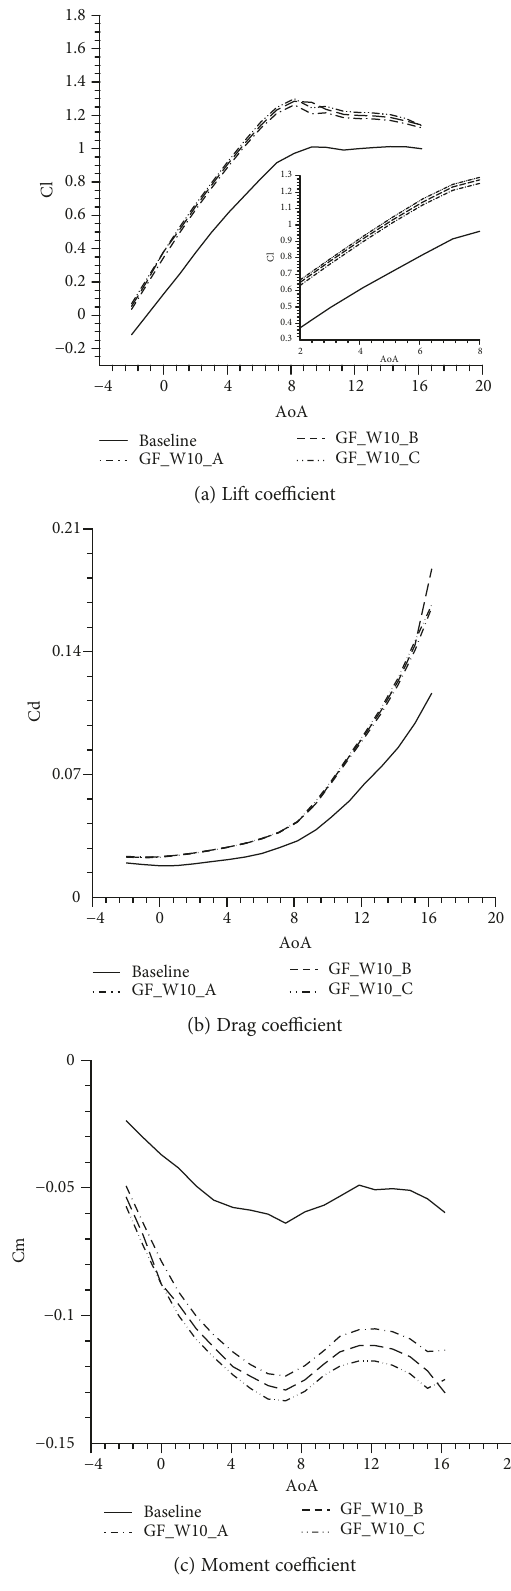
Figure 9: Aerodynamic coe ffi cient comparison of the airfoils under di ff erent Gurney fl ap